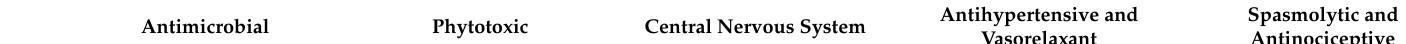
Table 3. Biological activity of extracts and compounds isolated from Agastache mexicana